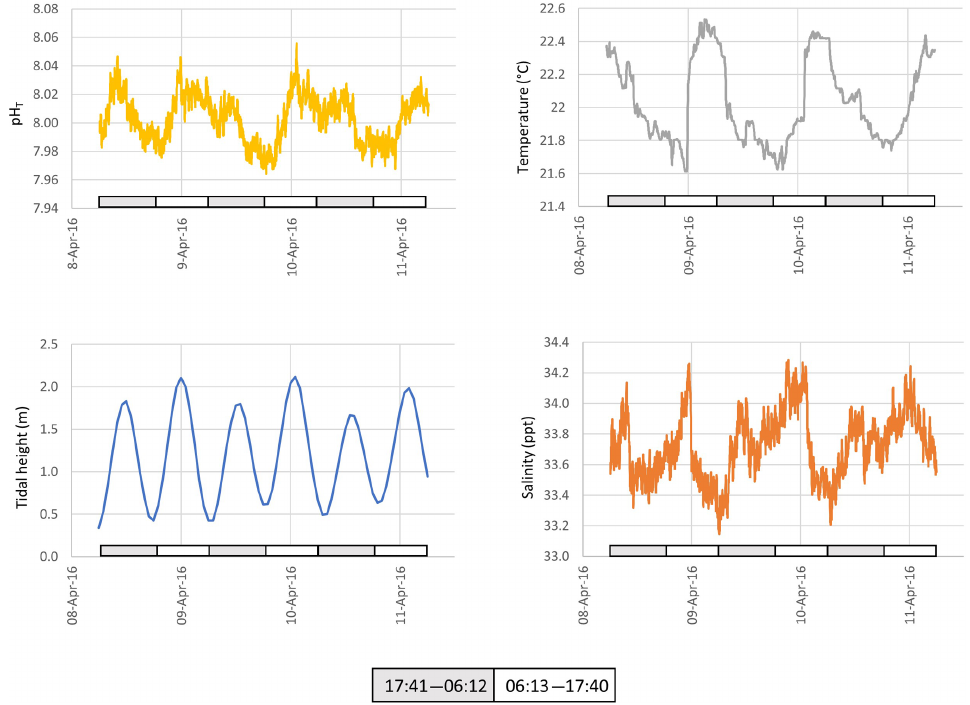
Figure 4. The pH, temperature, tidal height and salinity of seawater pumped from ∼ 1m below low water at Chowder Bay, Sydney over a 3-day period. Grey and white boxes indicate the time between sunset and sunrise.